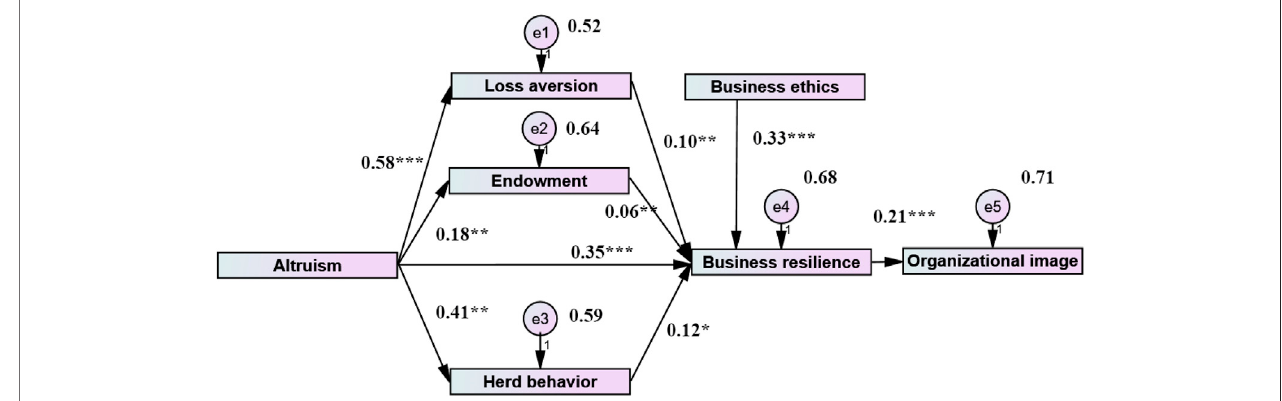
FIGURE 2 | Path diagram.